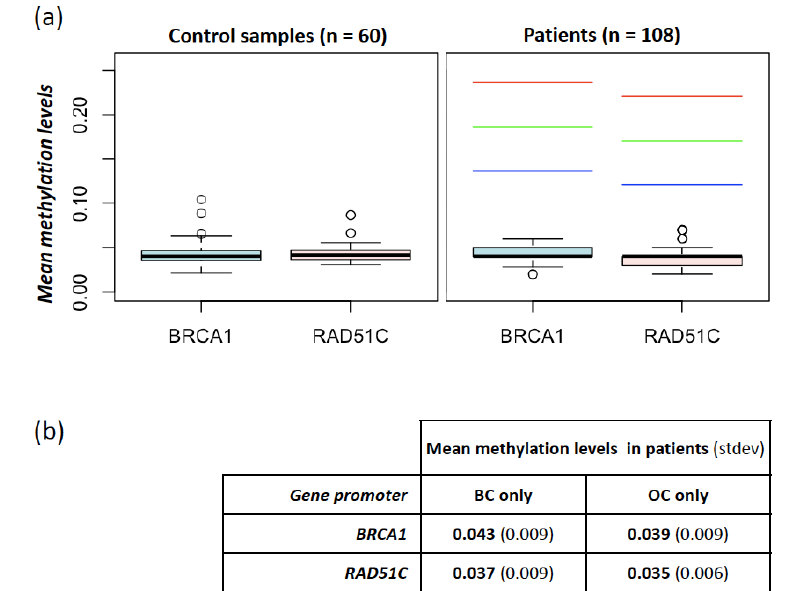
Figure 1. Methylation levels at BRCA1 and RAD51C promoters in controls and patients. ( a ) Mean methylation levels at BRCA1 and RAD51C promoters measured in 60 controls (left panel) and 108 patients (right panel). In the right panel, the red, green, and blue dashed lines indicate the thresholds used for the identification of hypermethylated cases obtained by adding the prefixed value of 0.15, 0.1, and 0.05, respectively, to the one-sided 95% bootstrap confidence interval of the controls’ mean; ( b ) mean methylation levels at BRCA1 and RAD51C promoters in samples stratified according to cancer localization (breast cancer (BC) only vs. ovarian cancer (OC) only).